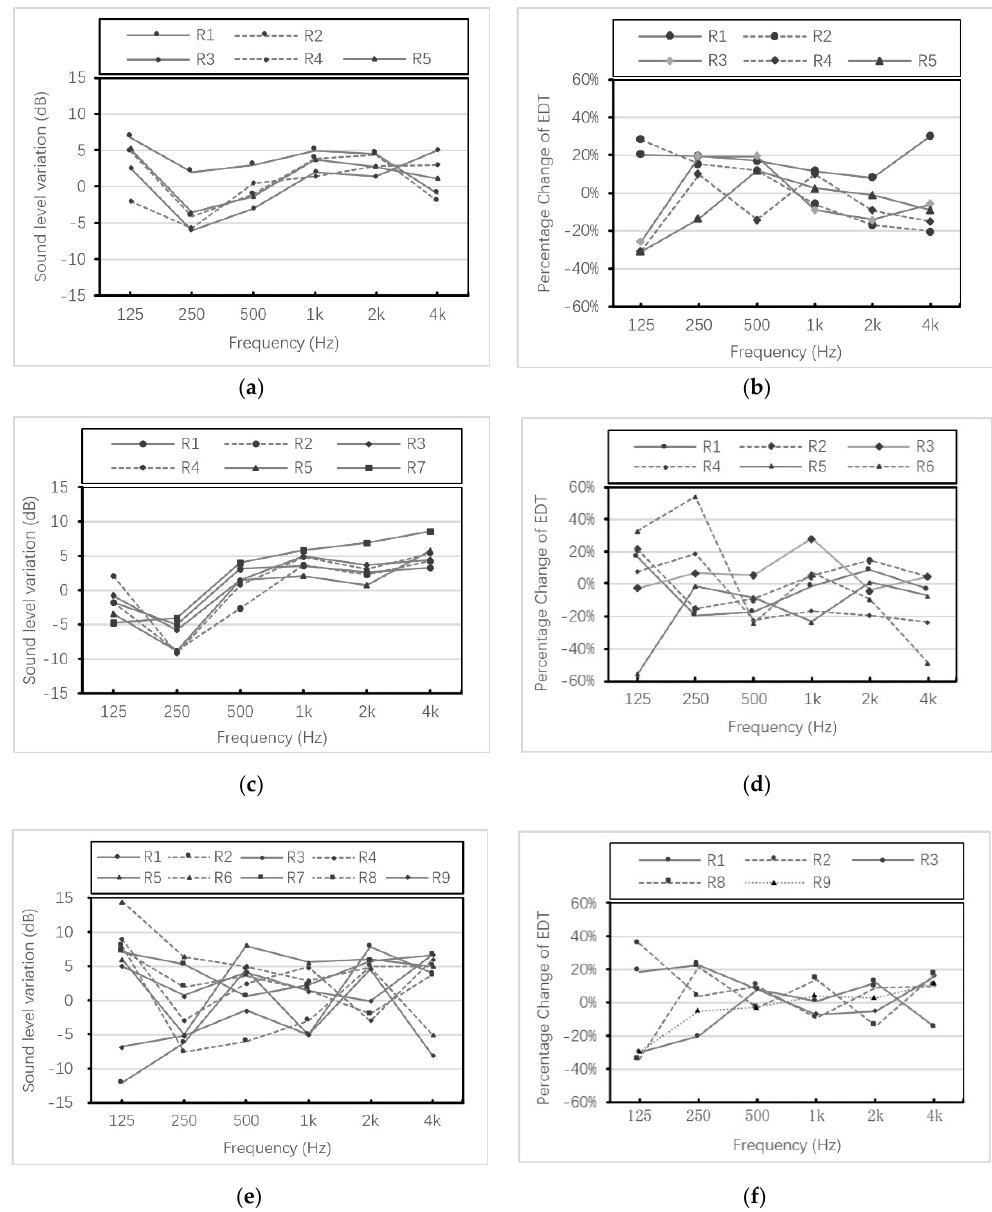
Figure 5. Broken-line graph of sound level differences and EDT percentage differences between measured and simulated results for Shenyang Imperial Palace courtyards. ( a ) Differences in Qingning Hall sound levels. ( b ) Percentage differences in Qingning Hall EDT. ( c ) Differences in East Hall sound levels. ( d ) Percentage differences in East Hall EDT. ( e ) Differences in West Hall sound levels. ( f ) Percentage differences in West Hall EDT. Table 2. Sound absorption coefficient and scattering coefficient of outdoor enclosure courtyard materials.